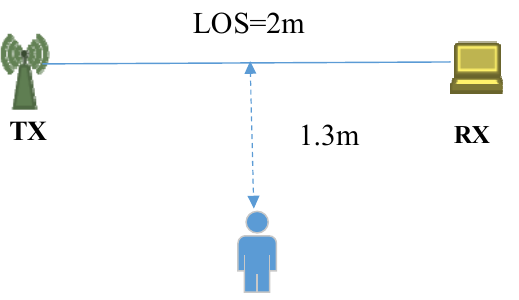
Figure 8. experimental setup. Figure 8. Experimental setup.